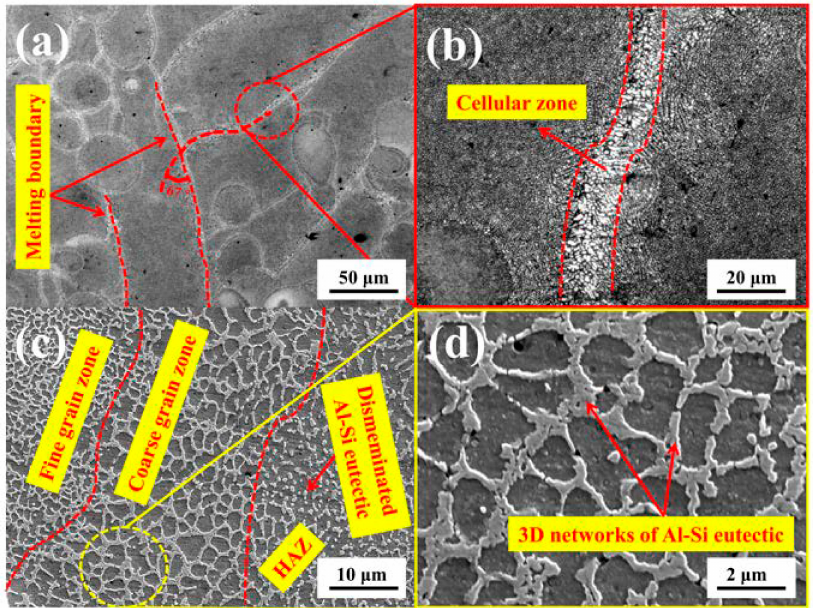
Figure 9. The microstructure of the tree column structures-type AlSi10Mg alloy branches on the cross-section: ( a , b ) Metallographic micrographs and ( c , d ) SEM micrographs.